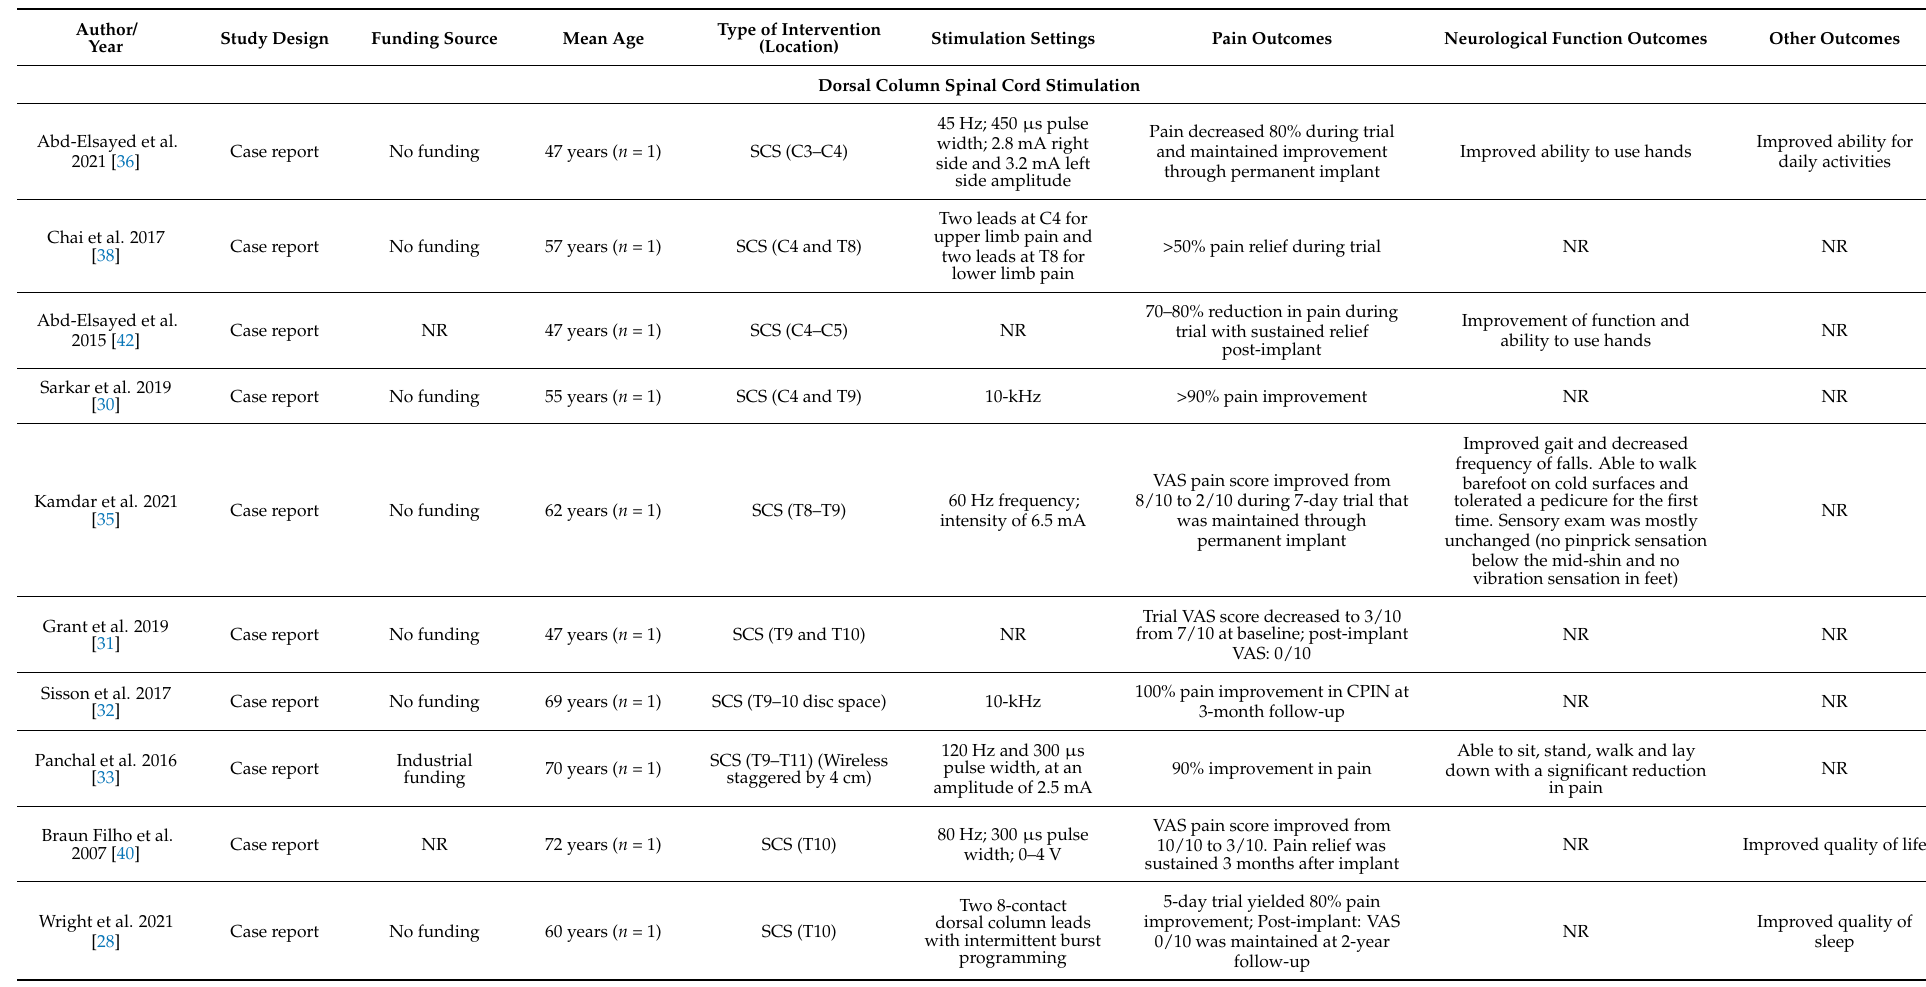
Table 1. Summary of Studies on Neuromodulation Interventions for Chemotherapy-Induced Peripheral